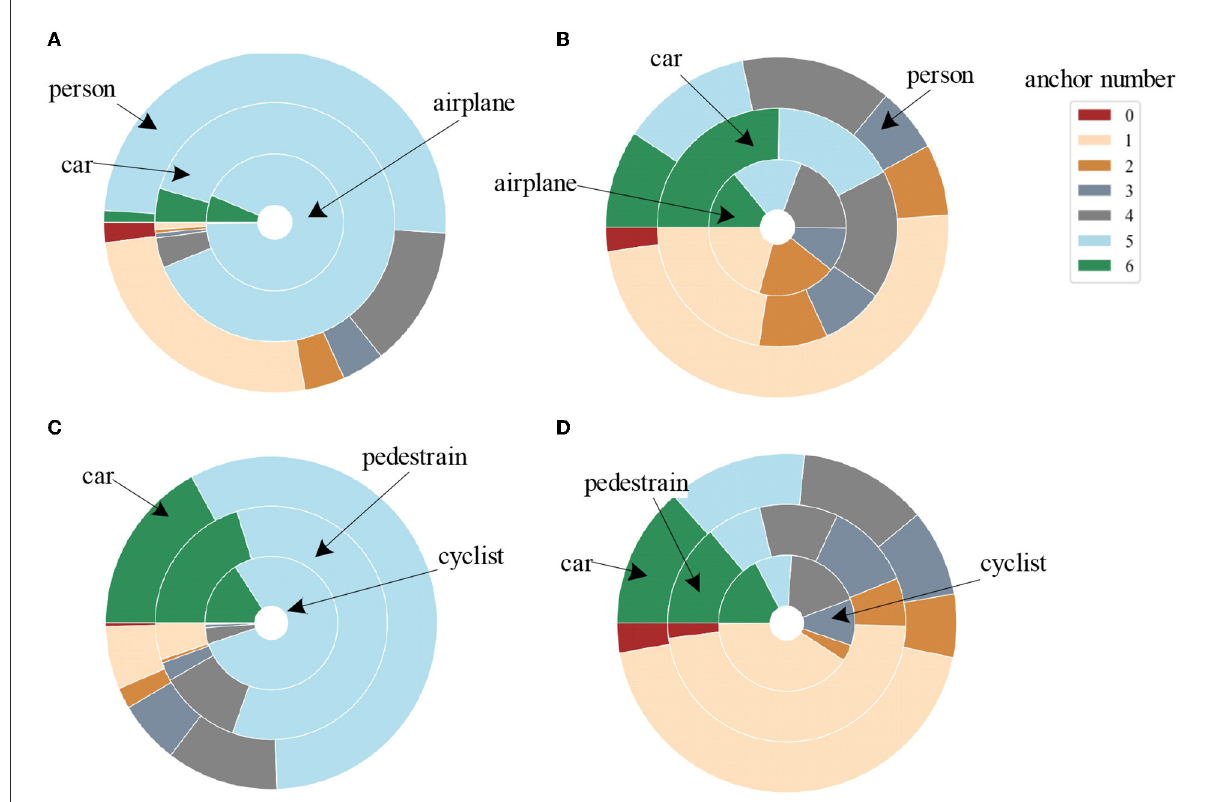
FIGURE4 Comparison of the number of matched anchors for different categories between our proposed matching strategy [ (A) for the airport dataset, (C) for the KITTI dataset] and the commonly used max-IOU matching strategy [ (B) for the airport dataset, (D) for the KITTI dataset]. Different concentric circles represent various categories of ground truth, and different colors indicate the number of anchors matched by each ground